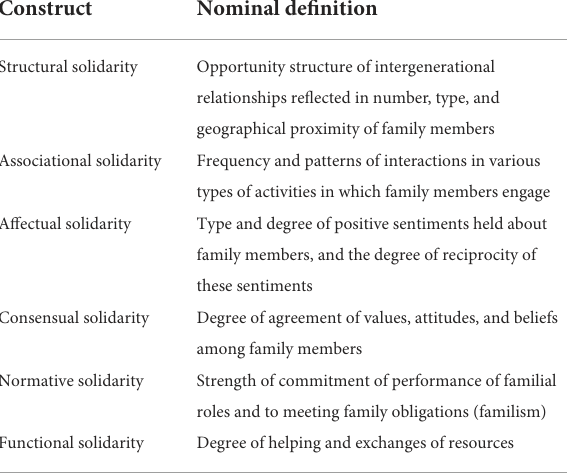
TABLE 1 Six elements of intergenerational solidarity with nominal